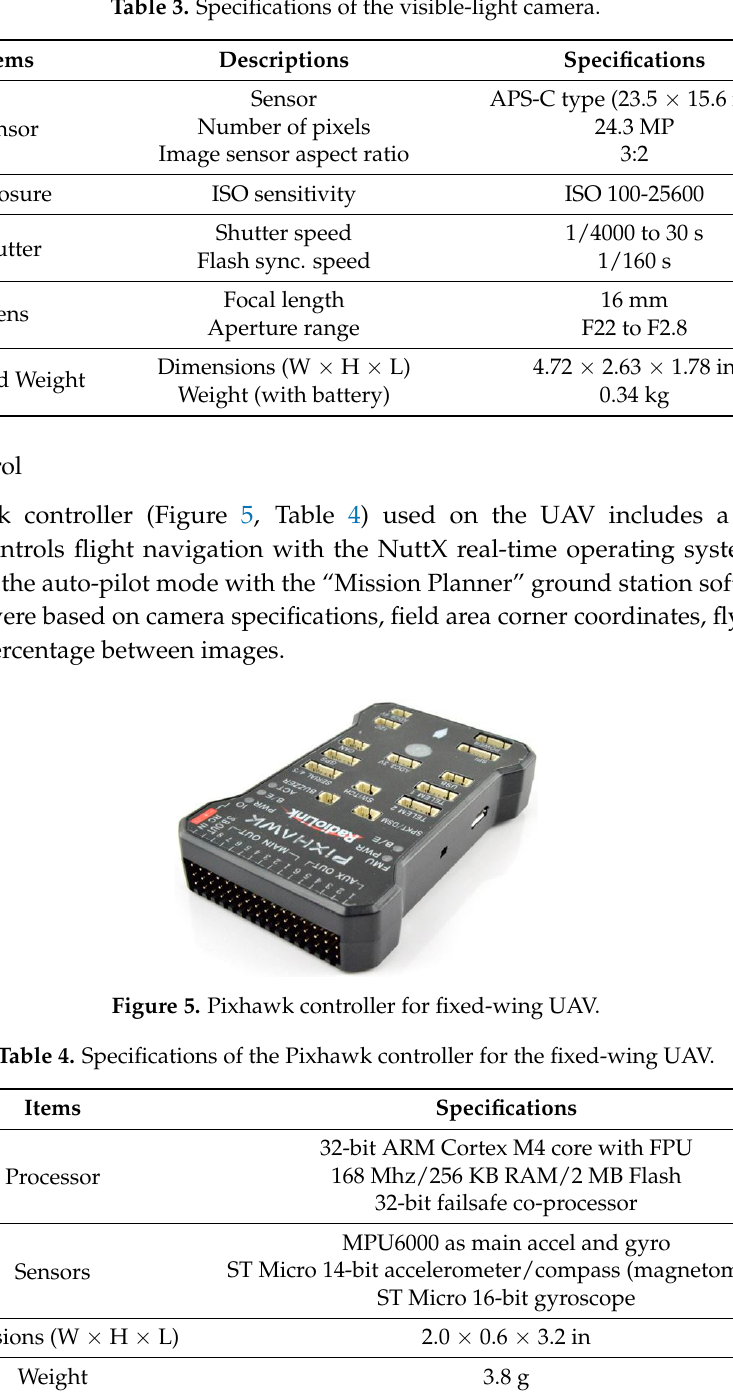
Figure 4. The visible-light camera used in this study.